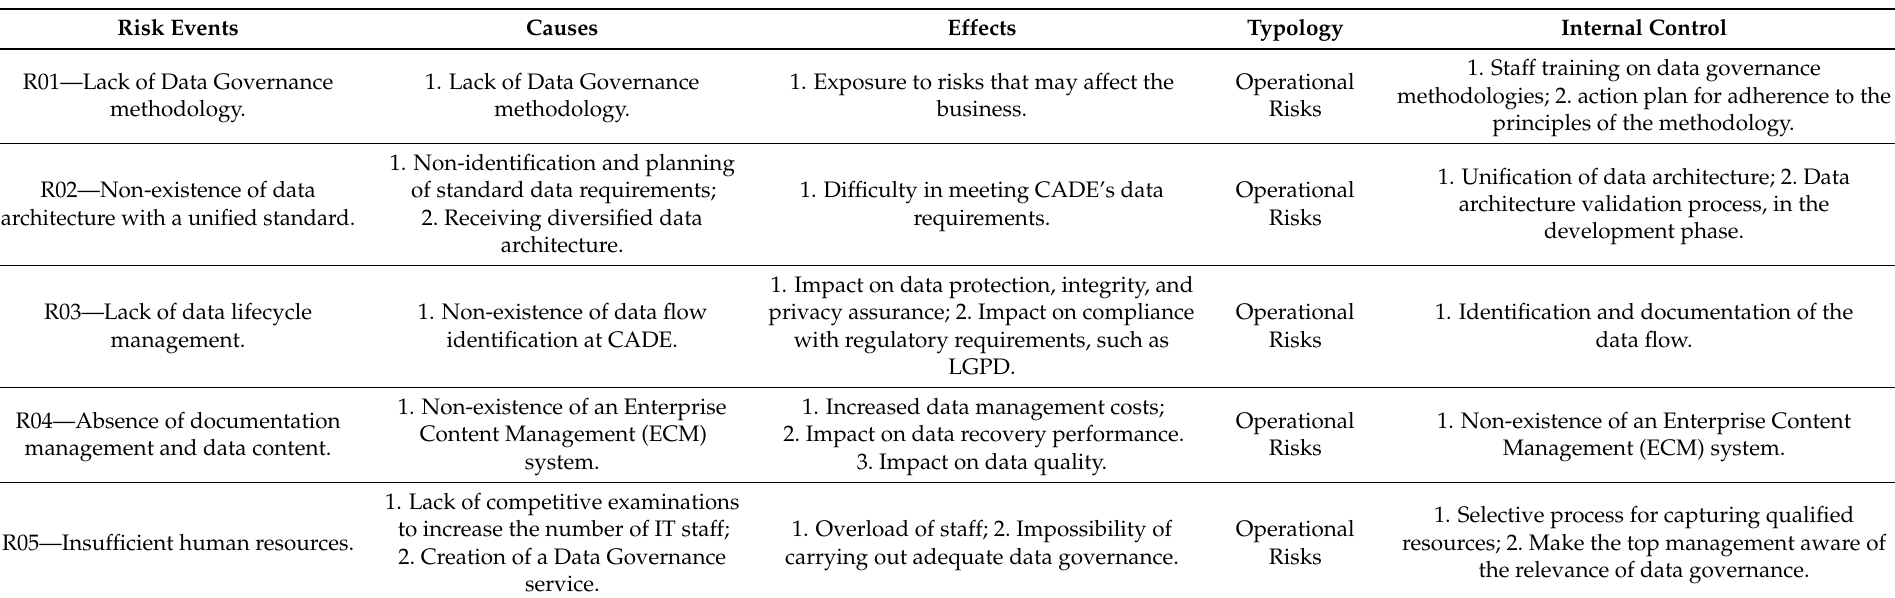
Table 5. Identified Risk Events in the Corporate Data Management